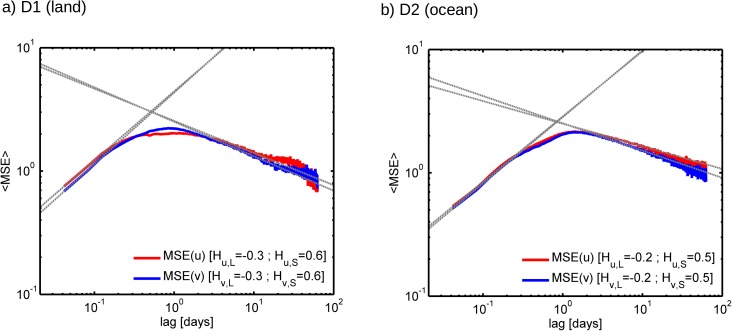
Log-log plots of ensemble averaged MSE computed from CFSR hourly time-series over sub-domain a) D1 and b) D2. The red lines correspond to zonal wind and the blue lines correspond to meridional wind. The dashed grey lines are the linear regression fits, with the corresponding slopes identified in the legend.